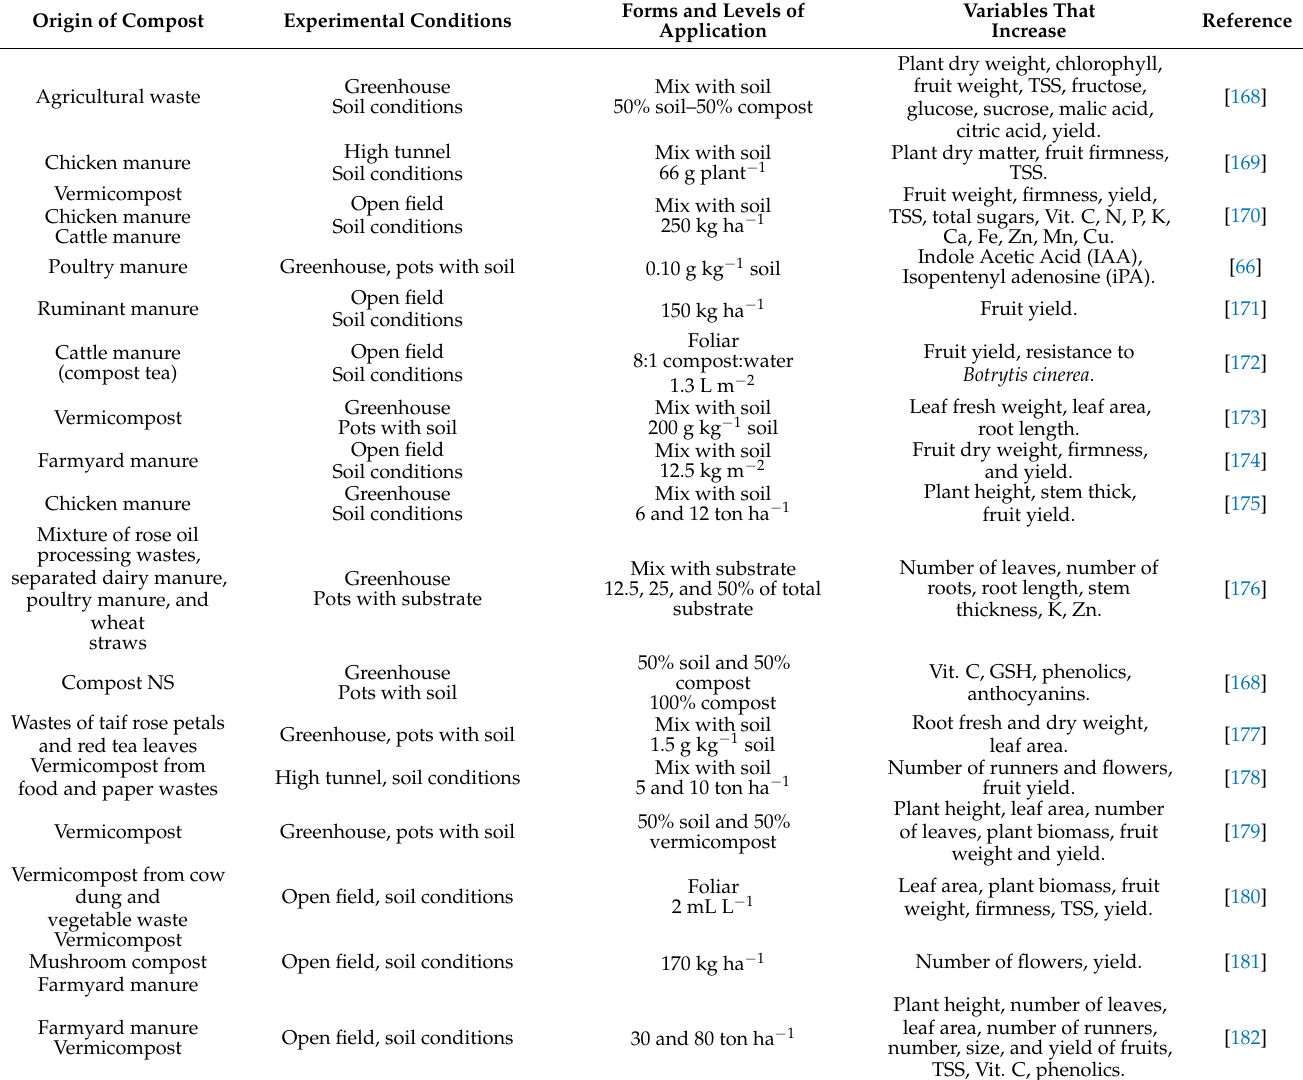
Table 7. Beneficial effects of compost applications on some growth or quality variables of strawberry